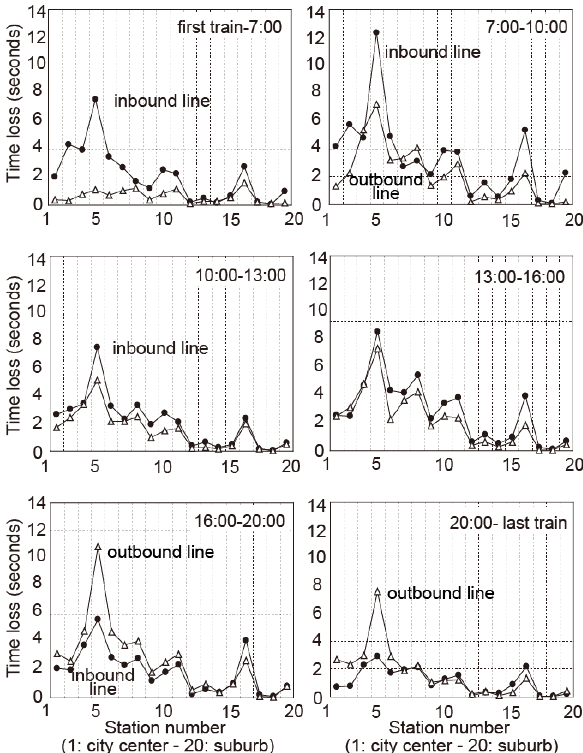
Figure 7 . Loss in time from boarding/alighting due to an uneven distribution of